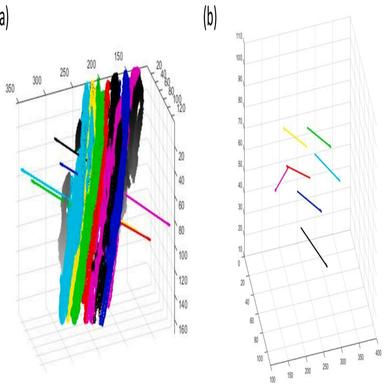
(a) Fitted planes to one of the most complex grains and (b) the corresponding unit vectors normal to the plane.